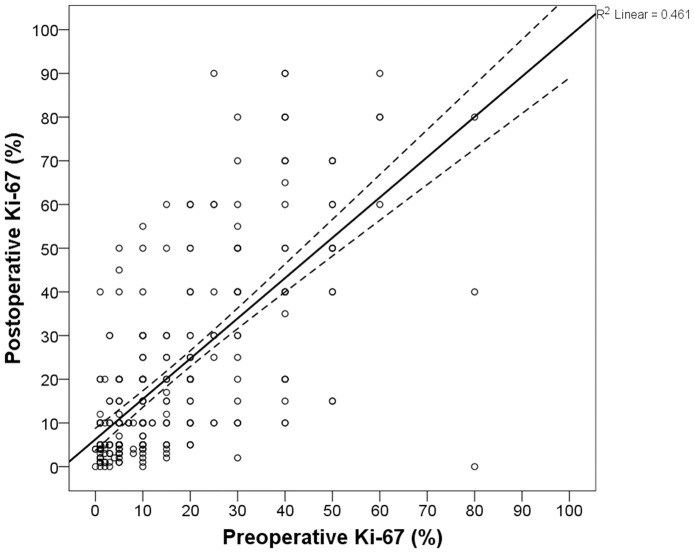
Comparison of Ki-67 expression between preoperative biopsy and postoperative surgical specimens.The solid line presents the best-fit correlation and the dotted lines show the 95% confidence interval.